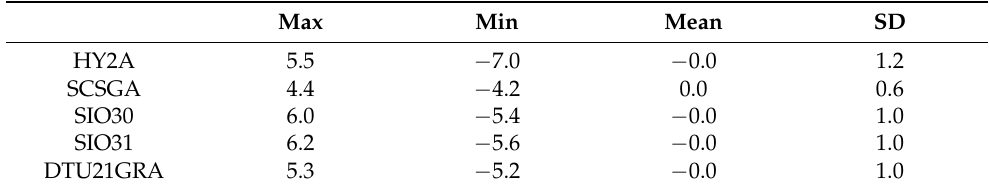
Table 3. Statistics of the residual quasi-geoid signals modeled with heterogeneous gravity models (units: cm). Max Min Mean SD HY2A 5.5 − 7.0 − 0.0 1.2 SCSGA 4.4 − 4.2 0.0 0.6 SIO30 6.0 − 5.4 − 0.0 1.0 SIO31 6.2 − 5.6 − 0.0 1.0 DTU21GRA 5.3 − 5.2 − 0.0 1.0